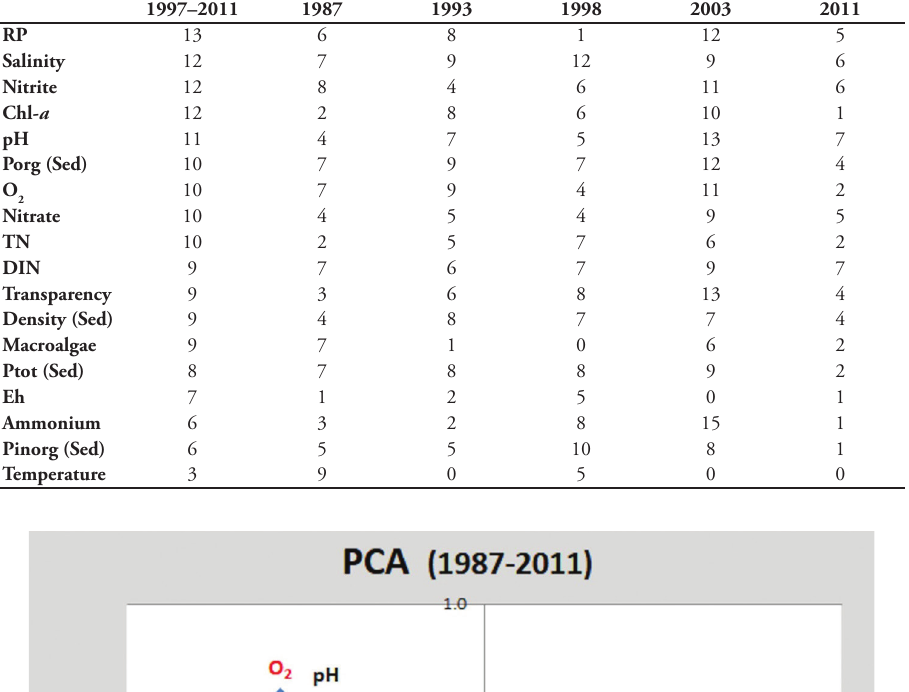
Table 4. Number of correlations among parameters.